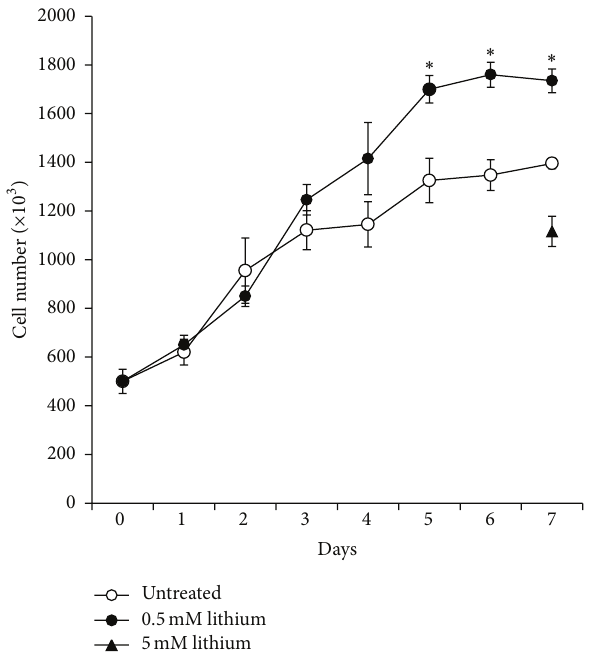
Figure1:ProliferationcurveofPC12cellstreatedwithlithium.Cells were treated with 0.5 mM lithium for 7 days and counted every day withtheTrypanblueexclusionmethod.Countsobtainedwith5 mM lithium at 7 days are shown as reference. Averages ± SEM of three independent experiments. ANOVA with Bonferroni’s-corrected 𝑡 - test. ∗ 𝑃 < 0.01 versus untreated control.